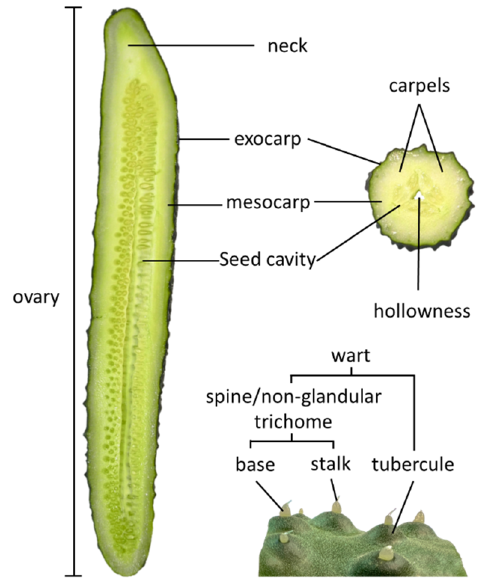
Figure 2. Structural features of cucumber fruit in longitudinal and